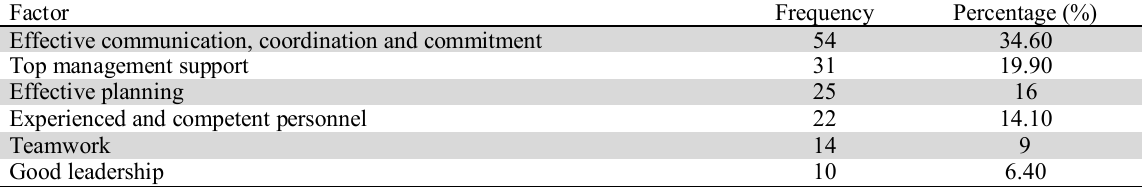
Project success factor in Ghana Source: Adapted from Ofori (2013) Factor Frequency Percentage (%) Effective communication, coordination and commitment